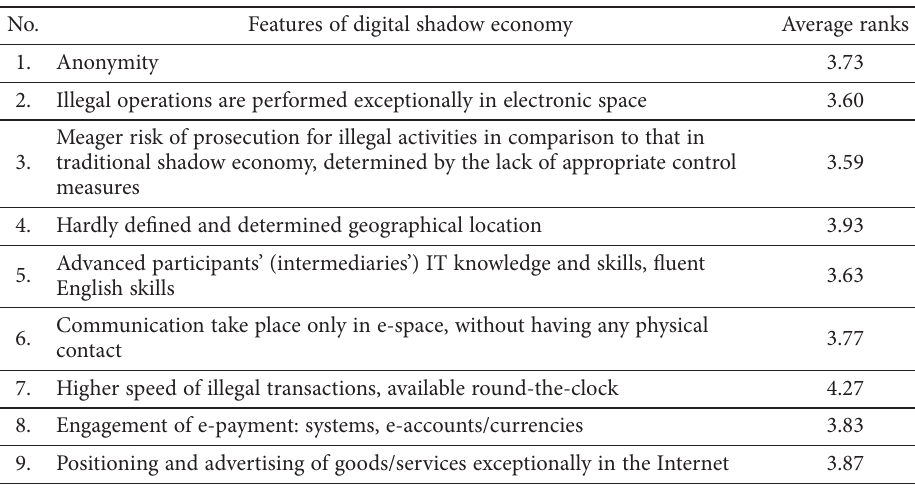
Table 5. Average ranks for the features of digital shadow economy